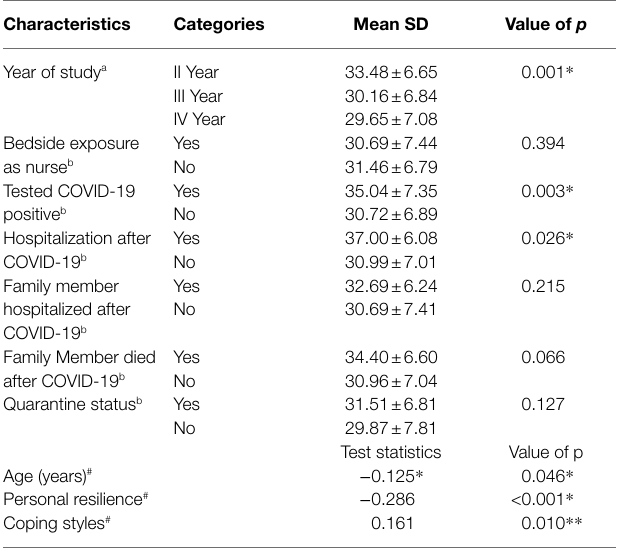
TABLE 2 | Relationship of lockdown fatigue with characteristics of the students ( n =